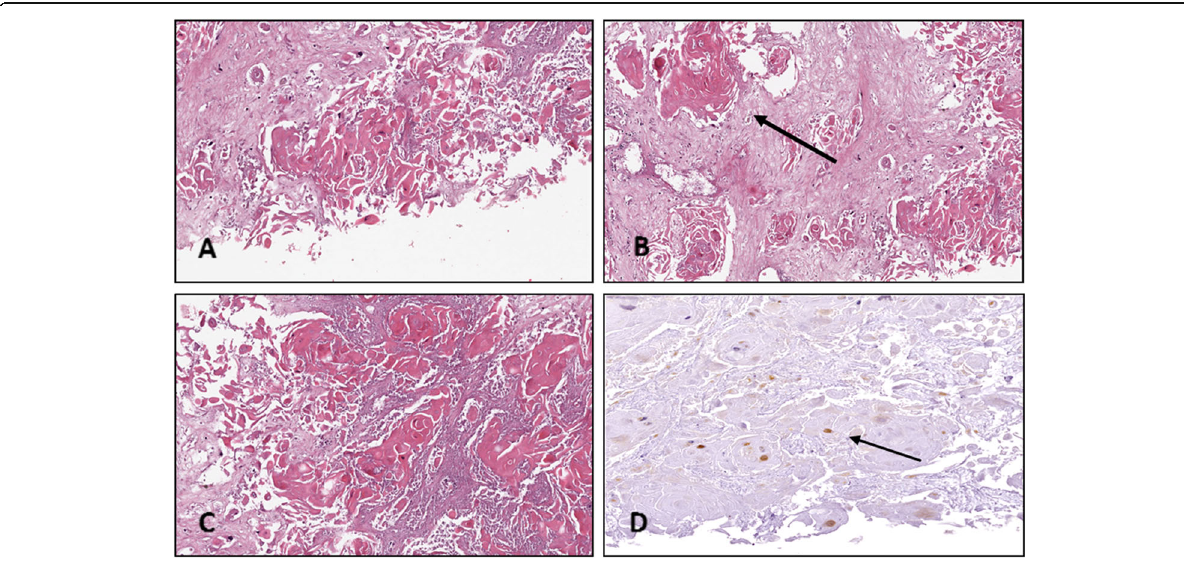
Fig. 2 a Showing a well-differentiated squamous cell carcinoma (H&E, × 100). b The tumor shows obvious squamous cell features such as seen here (arrow). c Well-differentiated lesion shows prominent keratinization and may form “ pearl-like ” structures (40 ×). Interposed areas of necrosis and fibrosis are evident. d Diffuse nuclear staining (arrow) for p63 in squamous neoplastic cells